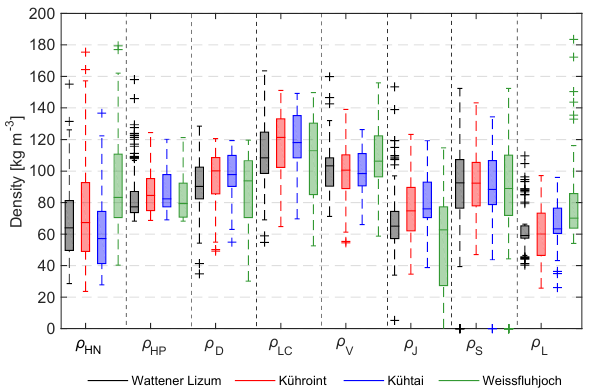
Figure 7. Box plots (median, 25 and 75% percentiles, 1.5 × interquartile ranges, outliers) of calculated new snow densi- ties ( ρ HN ) based on observations and densities calculated using pa- rameterizations developed in previous studies (Eqs. 3–9) at all four stations within period 1 (1 October 2013–20 May 2015). mean ρ HN of 72 kg m − 3 for a second group of smaller crys- tals and 99.4 kg m − 3 for graupel-type hydrometeors.